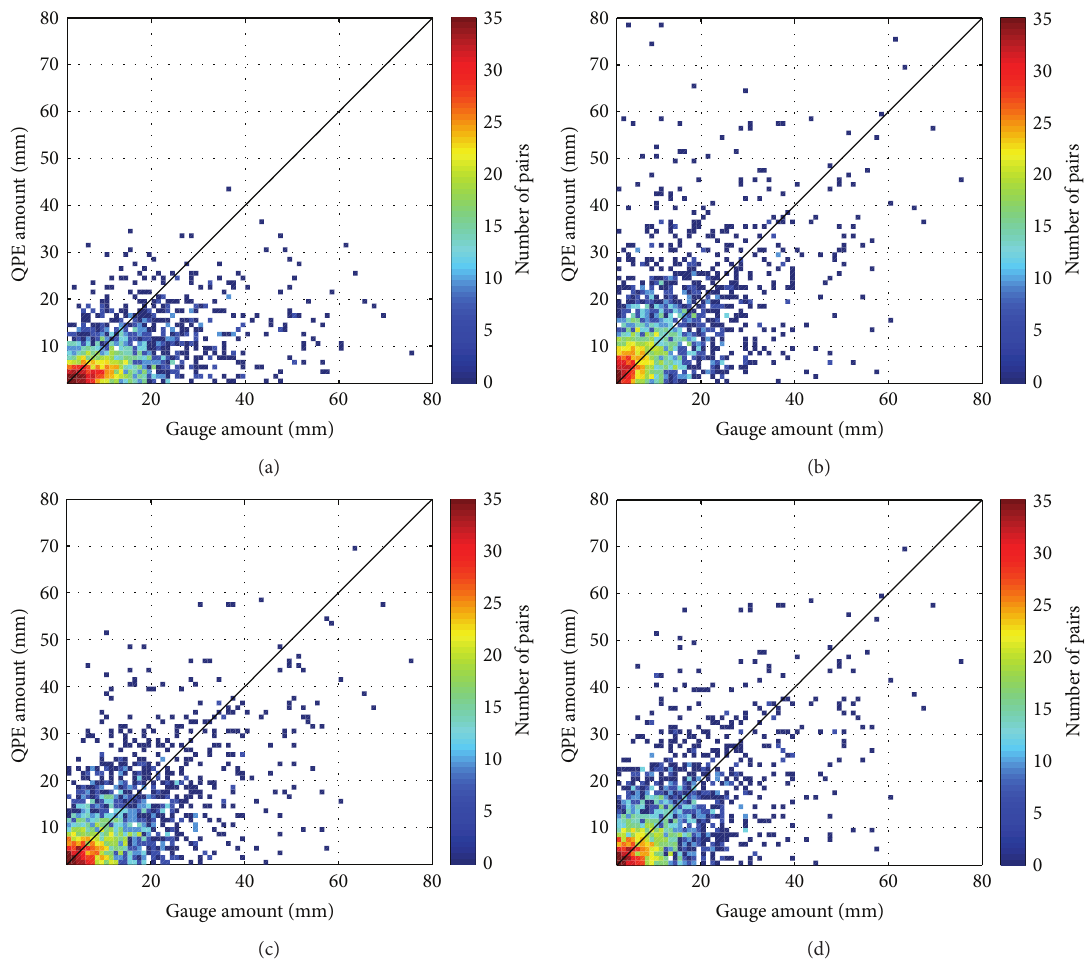
Figure 12: The comparison results between gauge network observations and QPE using (a) RZ, (b) RKDP, (c) CA, and (d) VCCA. 48-hour data from mei-yu precipitation (13 ∼ 14 June 2012) are selected, and a total of 4017 QPE-gauge pairs are used in the analysis.